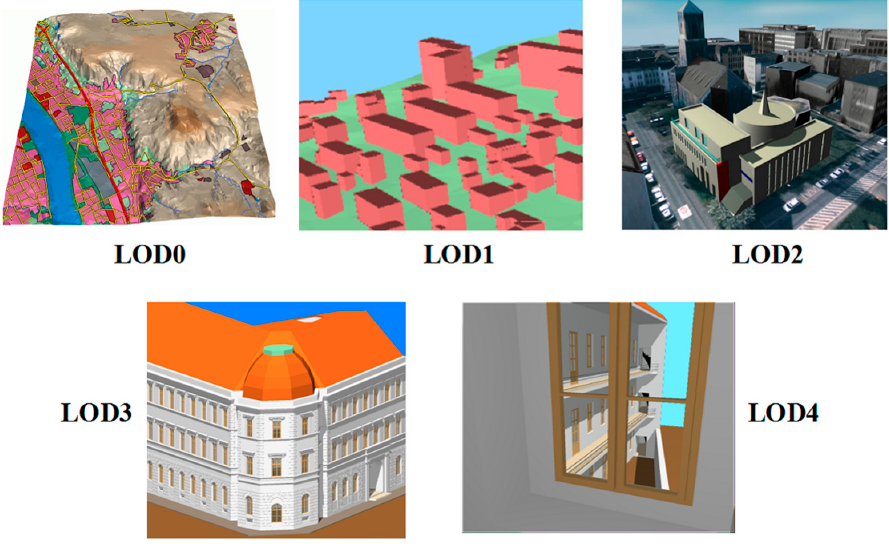
Figure 2. Levels of detail in CityGML (Image adapted from Kolbe (2009) [36]).